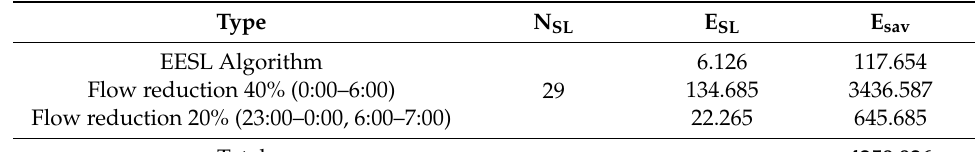
Table 10. Energy saved